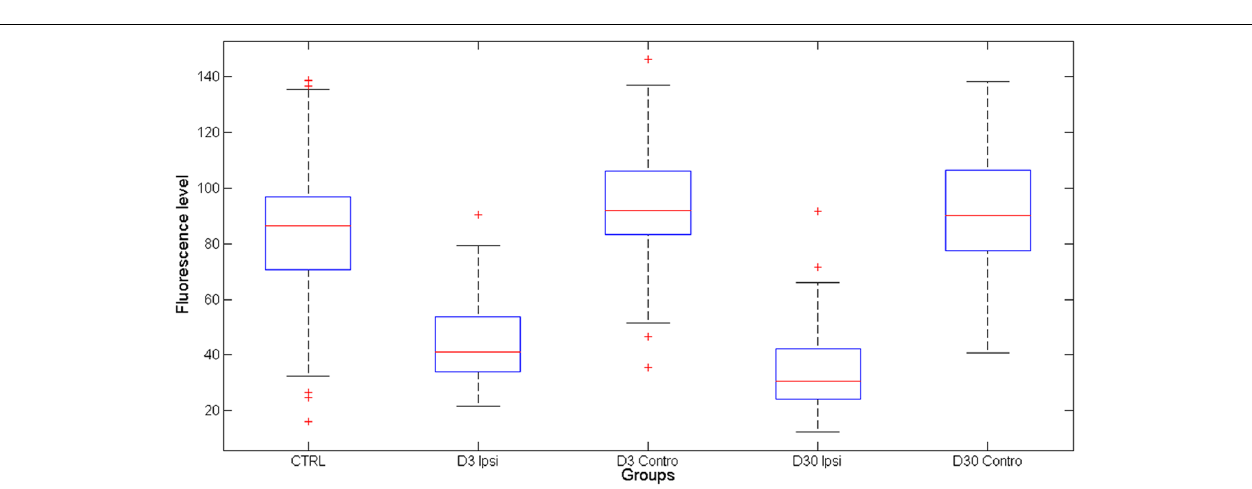
FIGURE 8 | Averaged KCC2-related fluorescence in control and lesioned (in CN ipsilateral and contralateral to the lesion) animals. KCC2 is strongly downregulated on the VCN ipsilateral to the